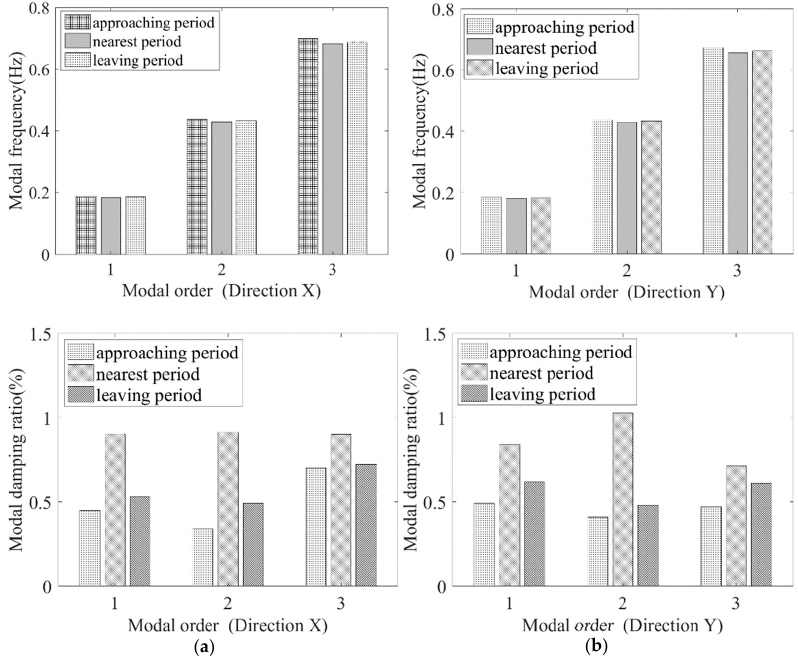
Figure 13. Natural frequencies and damping ratios at three periods during the passage of Mangkhut. ( a ) Dir-X; ( b ) Table 5. Values of natural frequency and damping ratio during three selected periods.